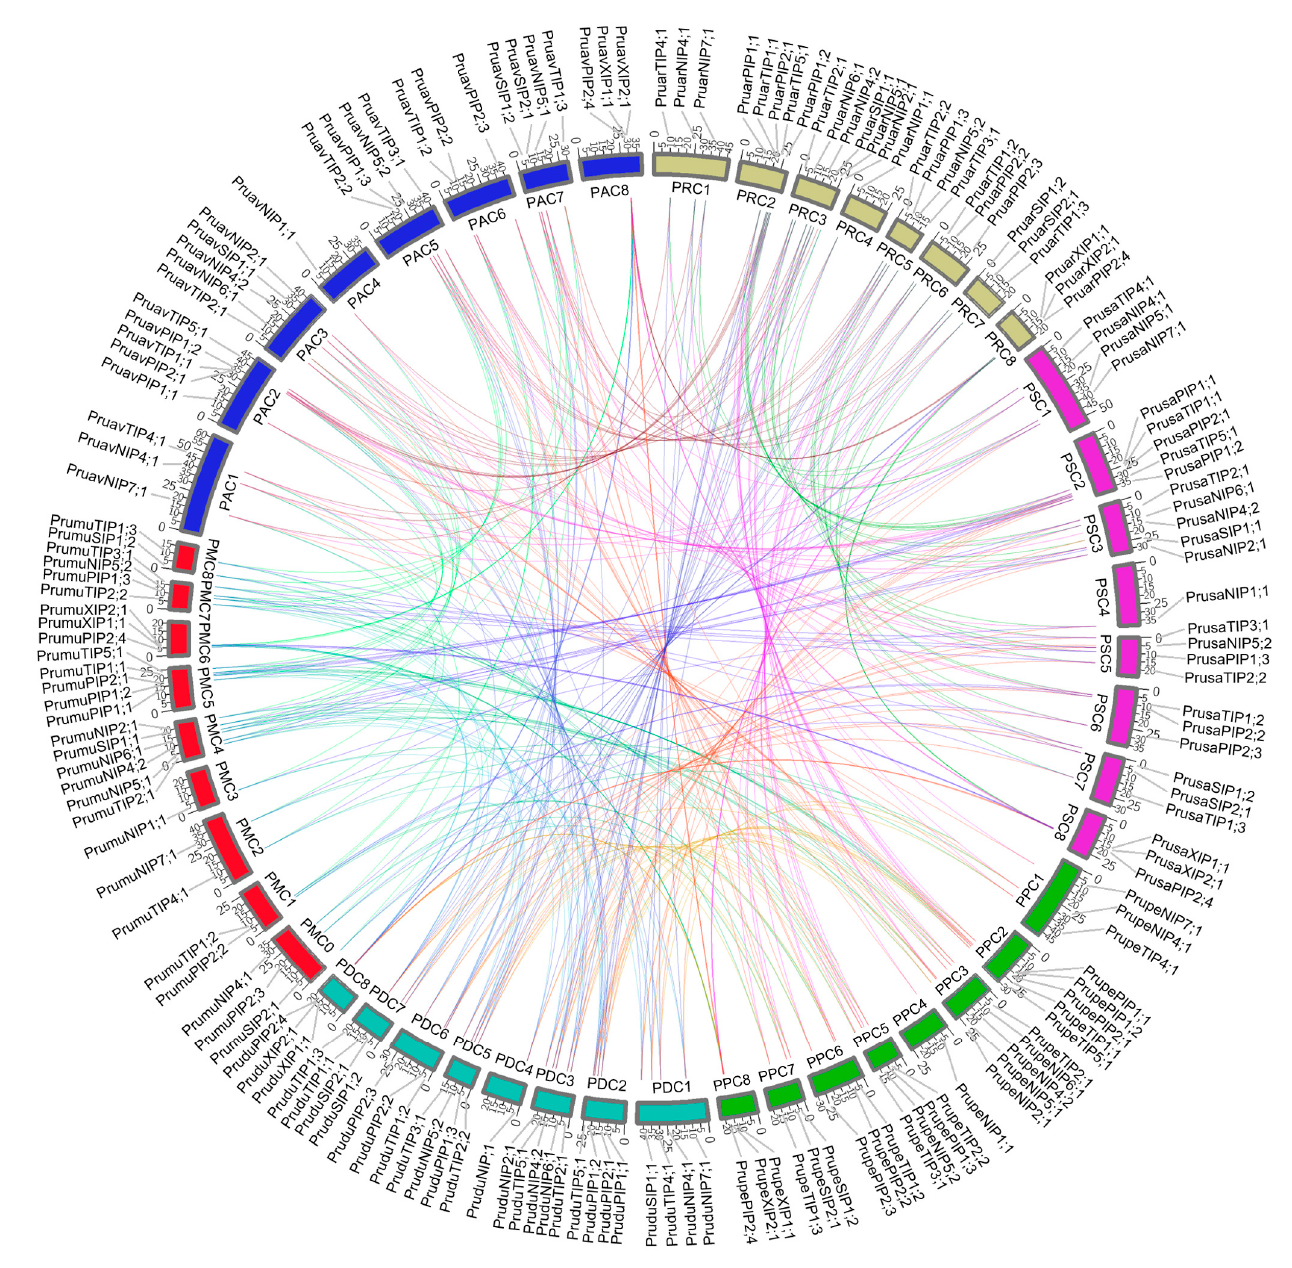
Figure 1. Analysis of synteny and chromosomal distribution of gene aquaporins from Prunus spp. PAC(1–8) represent the eight chromosomes from P. avium . The same case for P. mume , represented chromosomes as PMC(1–8), P. persica with PPC(1–8), P. armeniaca with PRC(1–8), P. dulcis with PDC(1–8) and P. salicina with PSC(1–8). Aquaporins with unplaced locations in P. mume are represented in PMC0 with reduced size so as to not distort the